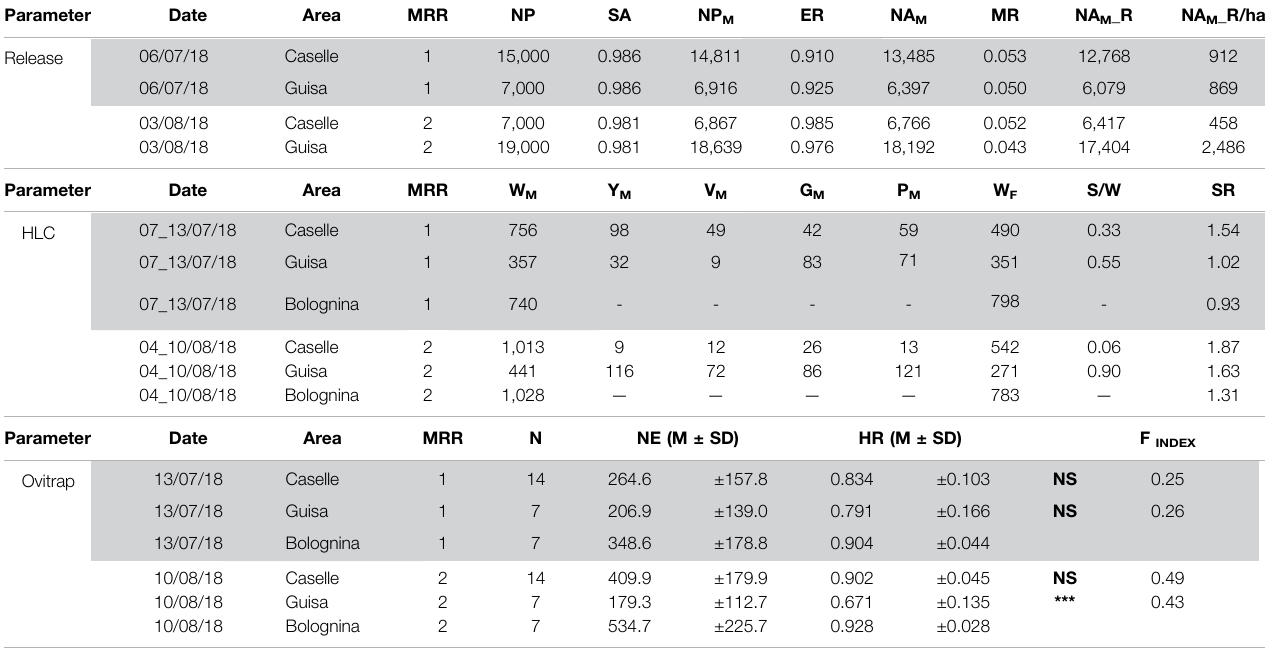
TABLE 1 | Main descriptive data of the MRR trials from rearing to release (Release). NP, number of pupae processed; SA, separation accuracy (sexing method); NP M , number of pupae male; ER, emergence rate; NA M , number of adult male; MR, mortality rate of the marked male at release; NA M _R, number of adult male released; NA M _R/ha,numberofadultmalereleasedperhectar(ha)usedinthetwolocalitiesofCaselle(14 haarea)andGuisaPepoli(7 haarea)duringthe fi rstandsecondMRRtrial.In HLC is reported the overall number of wild (W M male and W F female) and sterile marked adults (Y M , yellow male; V M , violet male; G M , green male; and P M , pink male) recapturedduringthehumanlandingrecapturesessionsinthedifferentMRRtrials.SterilemaleswerereleasedinCaselleandGuisaPepoli,whiletherecapturesessions were performed in all localities. The sterile to wild ratio (S/W) and the sex ratio (SR) calculated in the experimental areas are also reported. In ovitrap, the mean (M ± SD) number of eggs (NE), hatching rate (HR), and the relative Fried male competitiveness index (F INDEX ) calculated for each release localities are reported (See also Supplementary Materials S1 – S4